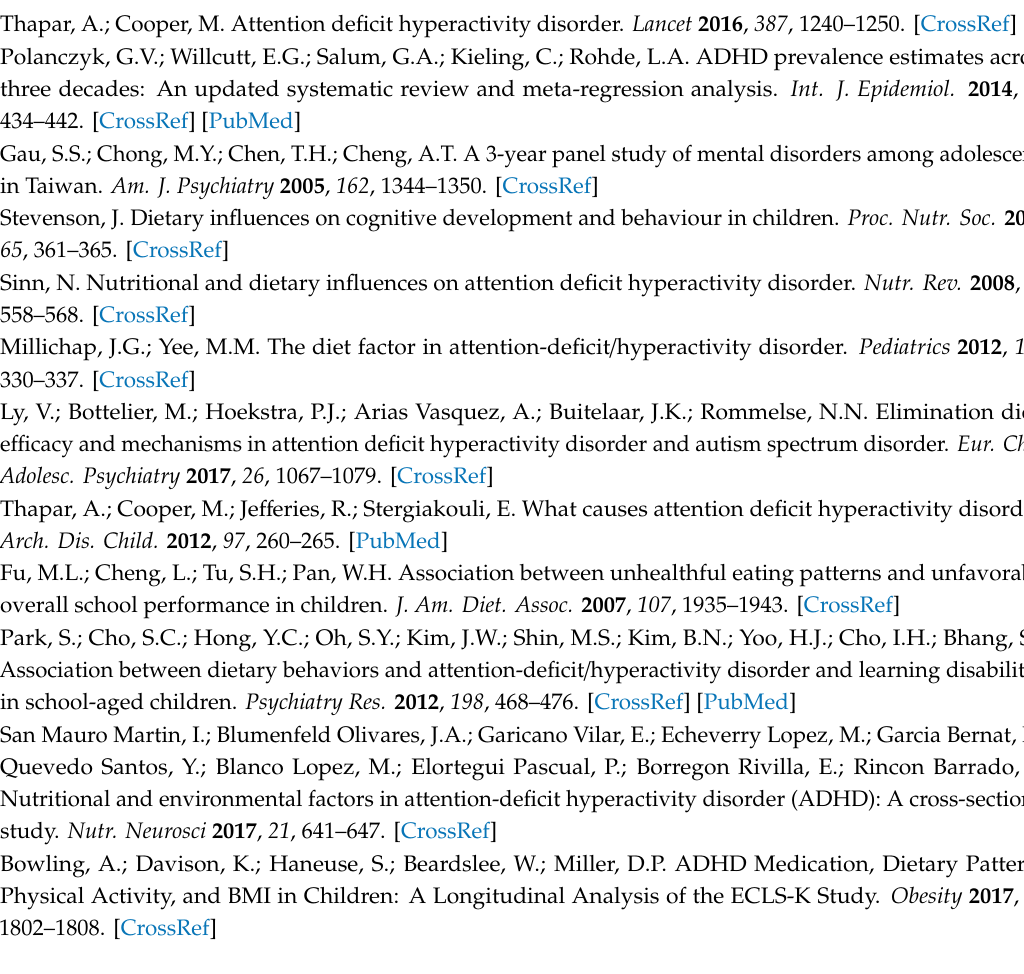
Table S1: Food preference between children with ADHD and healthy control children; Table S2: The relationship between ADHD, the dietary factors and the nutritional biochemistry